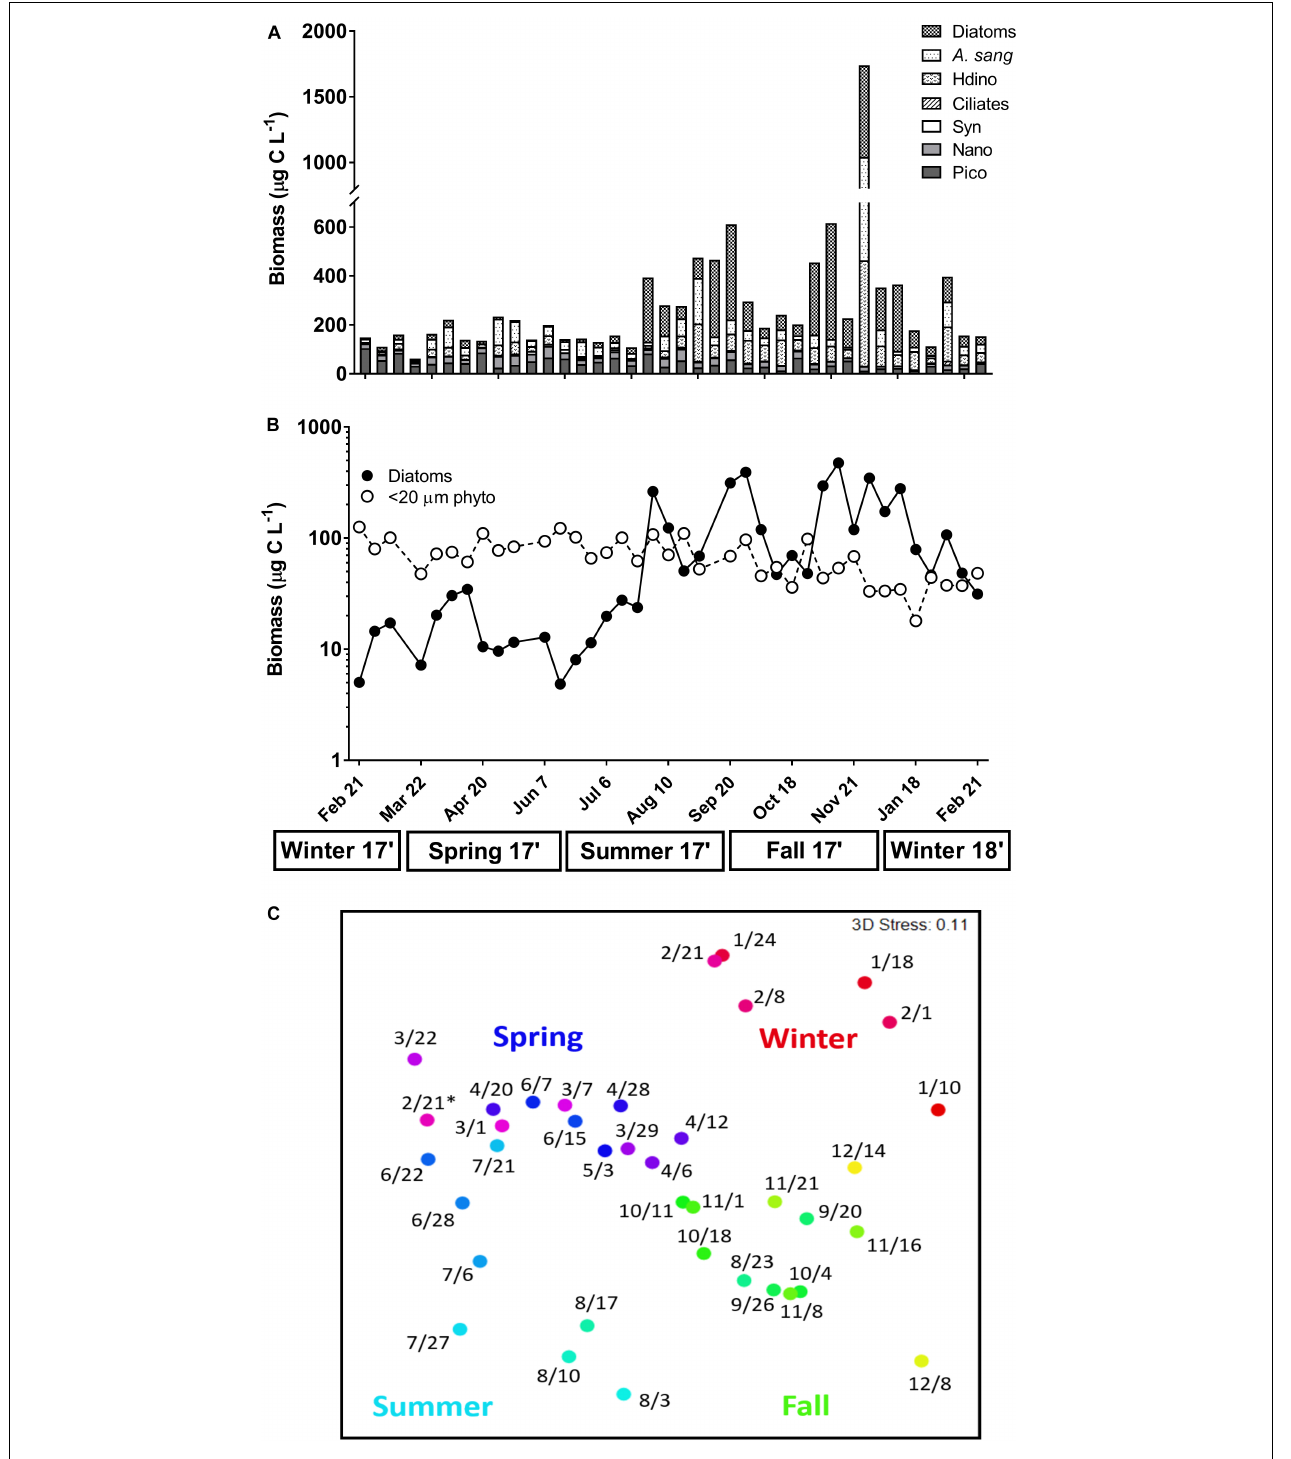
FIGURE 2 | (A) Carbon biomass ( µ g C L − 1 ) of plankton groups measured via FlowCam [diatoms; Akashiwo sanguinea ( A. sang) ; heterotrophic dinoflagellates (Hdino); ciliates] and flow cytometry [ Synechococcus spp. (Syn); Nanoeukaryotes (Nano); Picoeukaryotes (Pico)] at the start of each weekly experiment. (B) Log-transformed biomass of < 20 µ m combined phytoplankton (Syn, Nano, Pico; open symbols) versus diatoms (closed symbols). (C) Non-multidimensional scaling (NMDS) of total plankton composition on each sampling day (month/day) using log-transformed carbon biomass from (A) . A color gradient based on day of year (red = winter; purple = spring; blue = summer; green = fall) was applied to observe weekly and seasonal differences in composition. Asterisk above 2/21 indicates first sampling day in 2017. Seasons are listed below the x -axis.